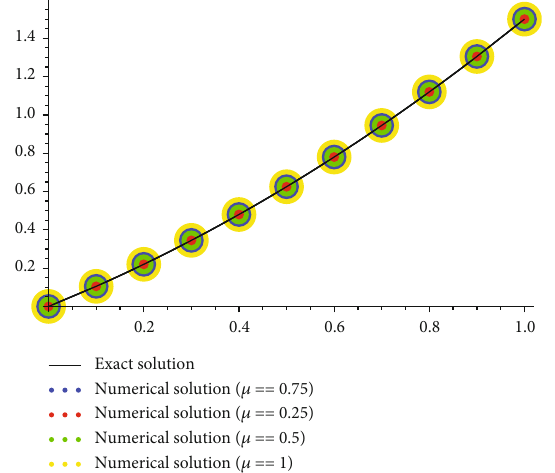
μ = 0 : 75,0 : 5,0 : 25,1 for 1 with